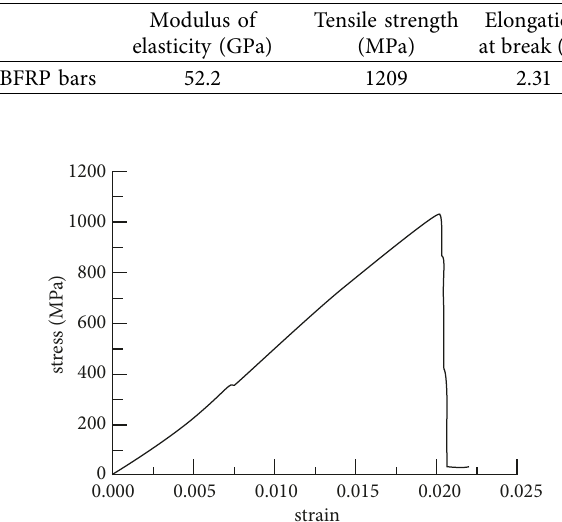
Figure 1: Stress-strain curves of BFRP